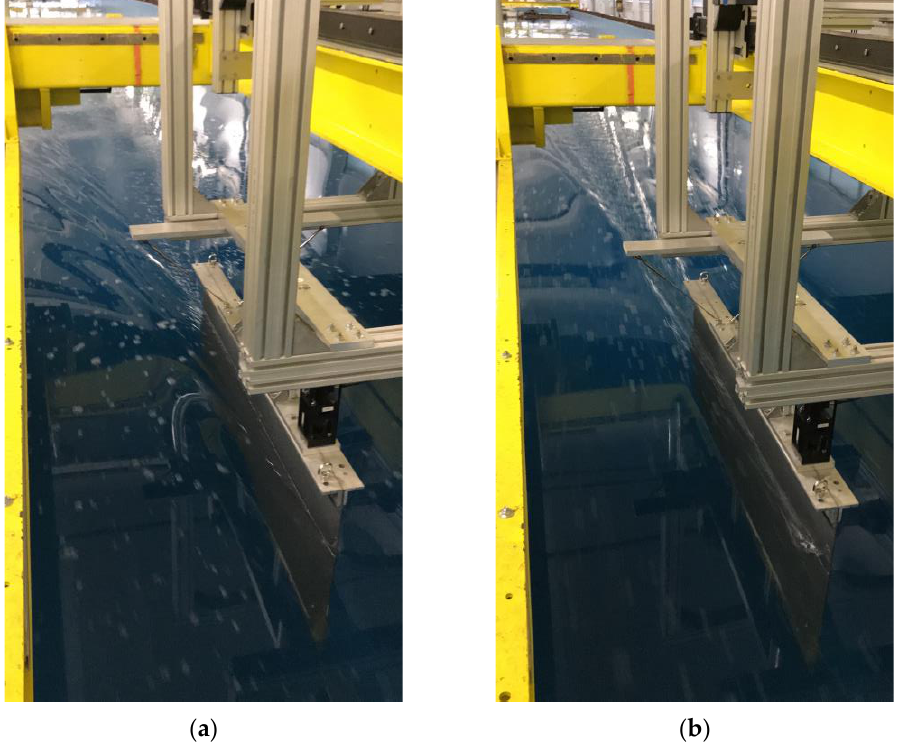
Figure 11. Towing tank experiments of a flat plate coated with Sand 220 towed at: ( a ) 1.5 m/s; ( b ) 4.5 m/s used for comparison with the present FTFC tests [24].